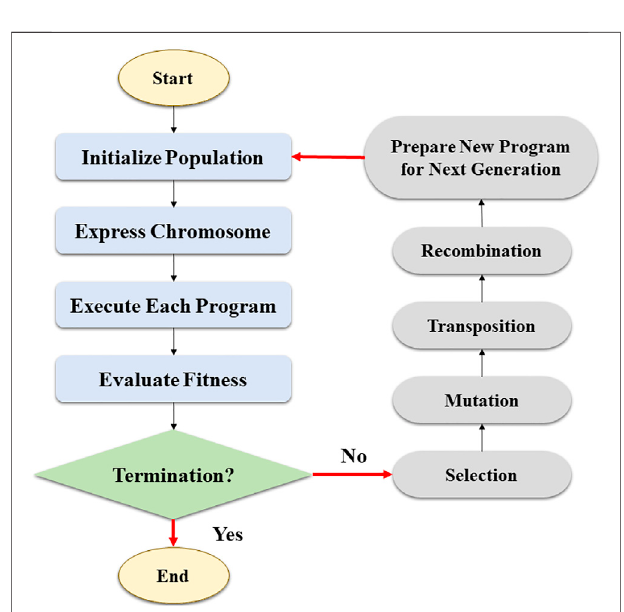
FIGURE 4 | Schematical representation of GEP fl owchart (Ferreira,